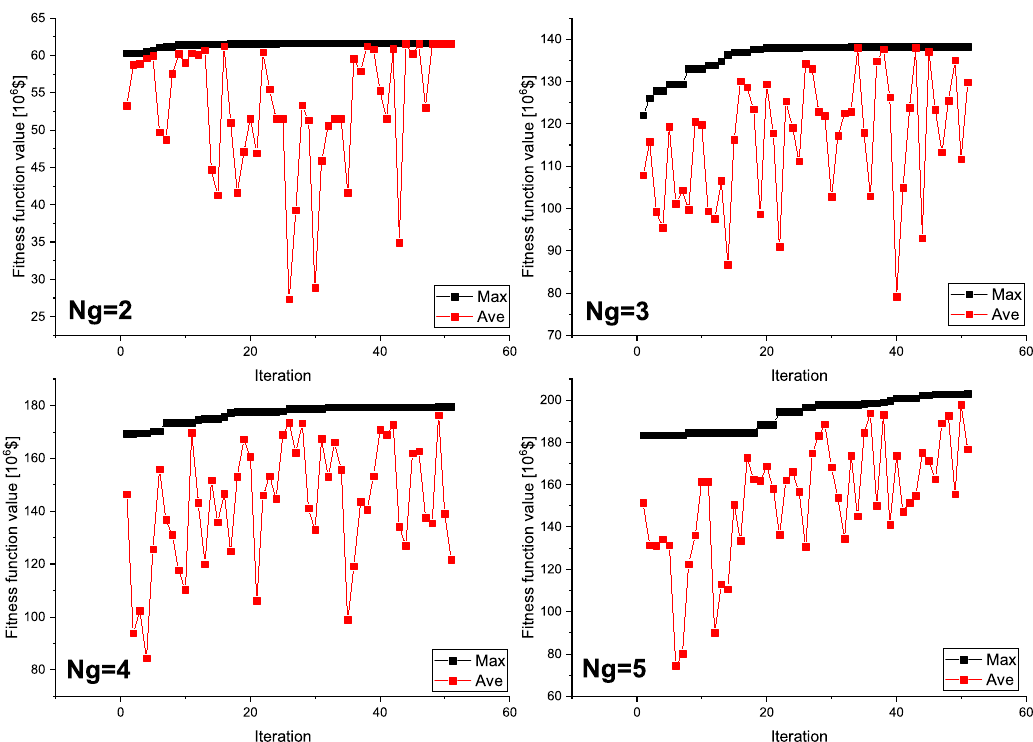
Figure 20. Changing the value of the objective function (maximum-max and averange-avg) during GA progress.